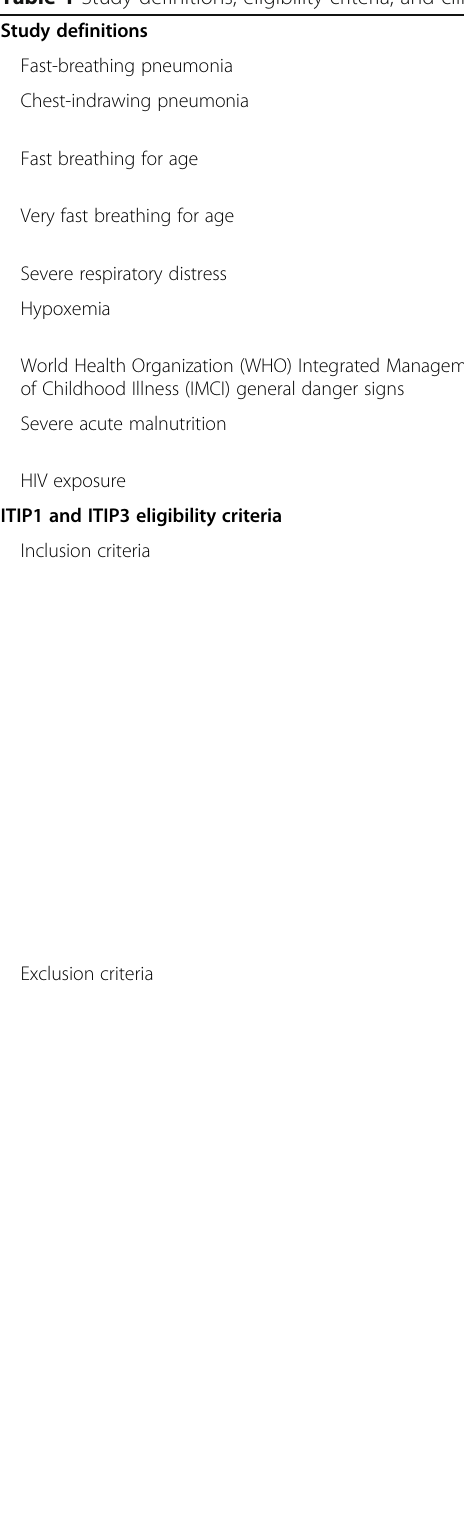
Table 1 Study definitions, eligibility criteria, and clinical